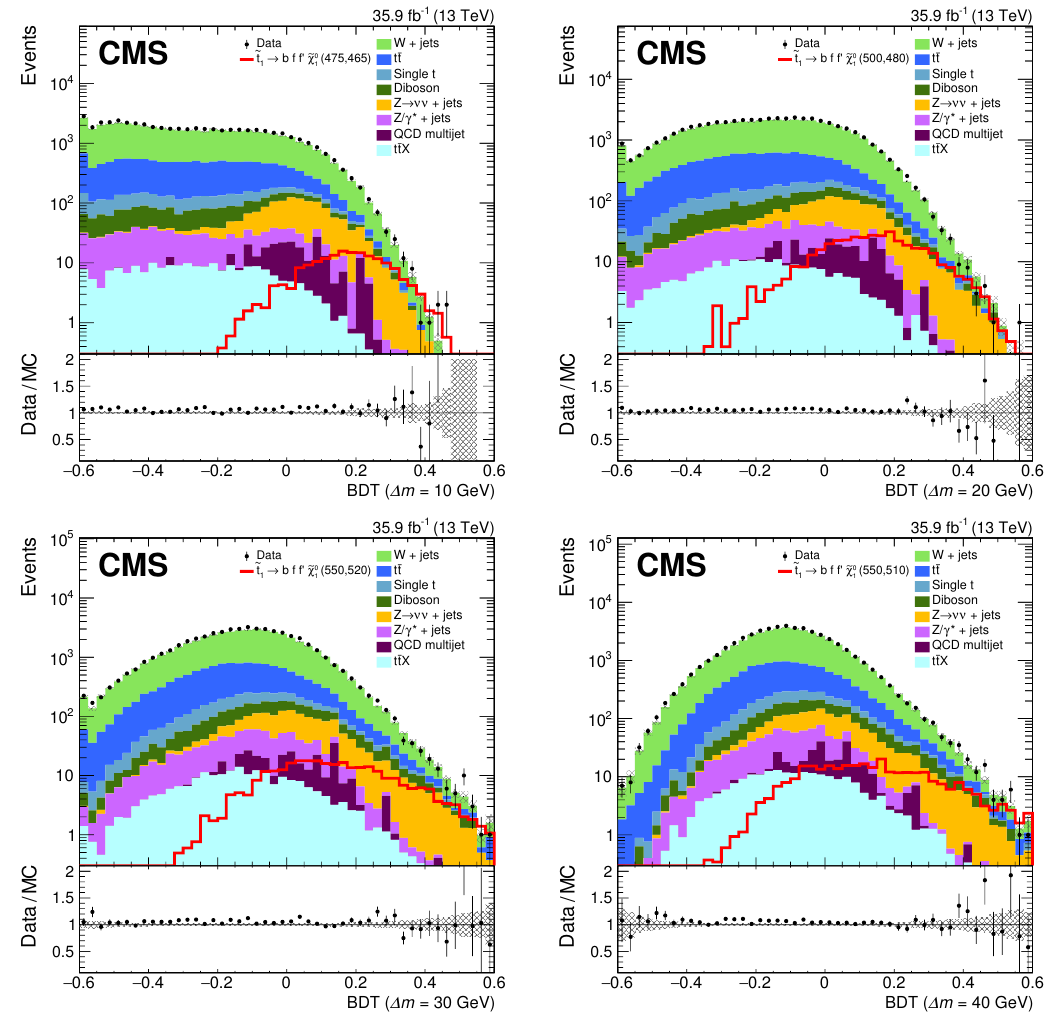
Figure 4 . Distributions of the BDT output at the preselection level in data and simulation in 10 GeV steps of (cid:1) m from 10 (top-left) to 40 GeV (bottom-right). For each case, a representative ( m ( t 1 ) ; m ( (cid:31) 0 )) signal point is also shown, but is not added to the SM background. The shaded 1 area on the Data/MC ratio represents the statistical uncertainty of the simulated e e